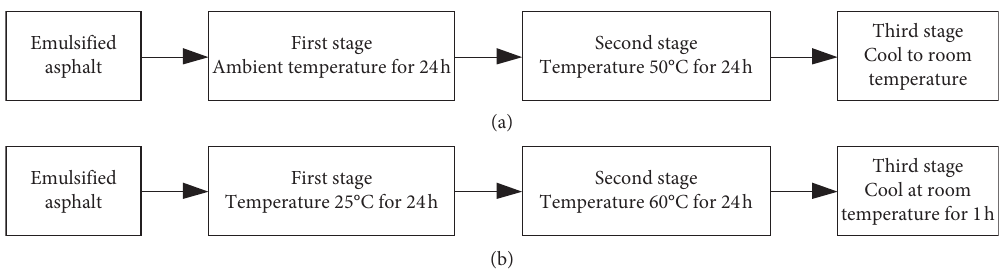
Figure 2: Recovery procedure of emulsified asphalt residues, (a) recovery procedure of emulsified asphalt residues according to EN13074, (b) recovery procedure of emulsified asphalt residues according to ASTM D7497-09.